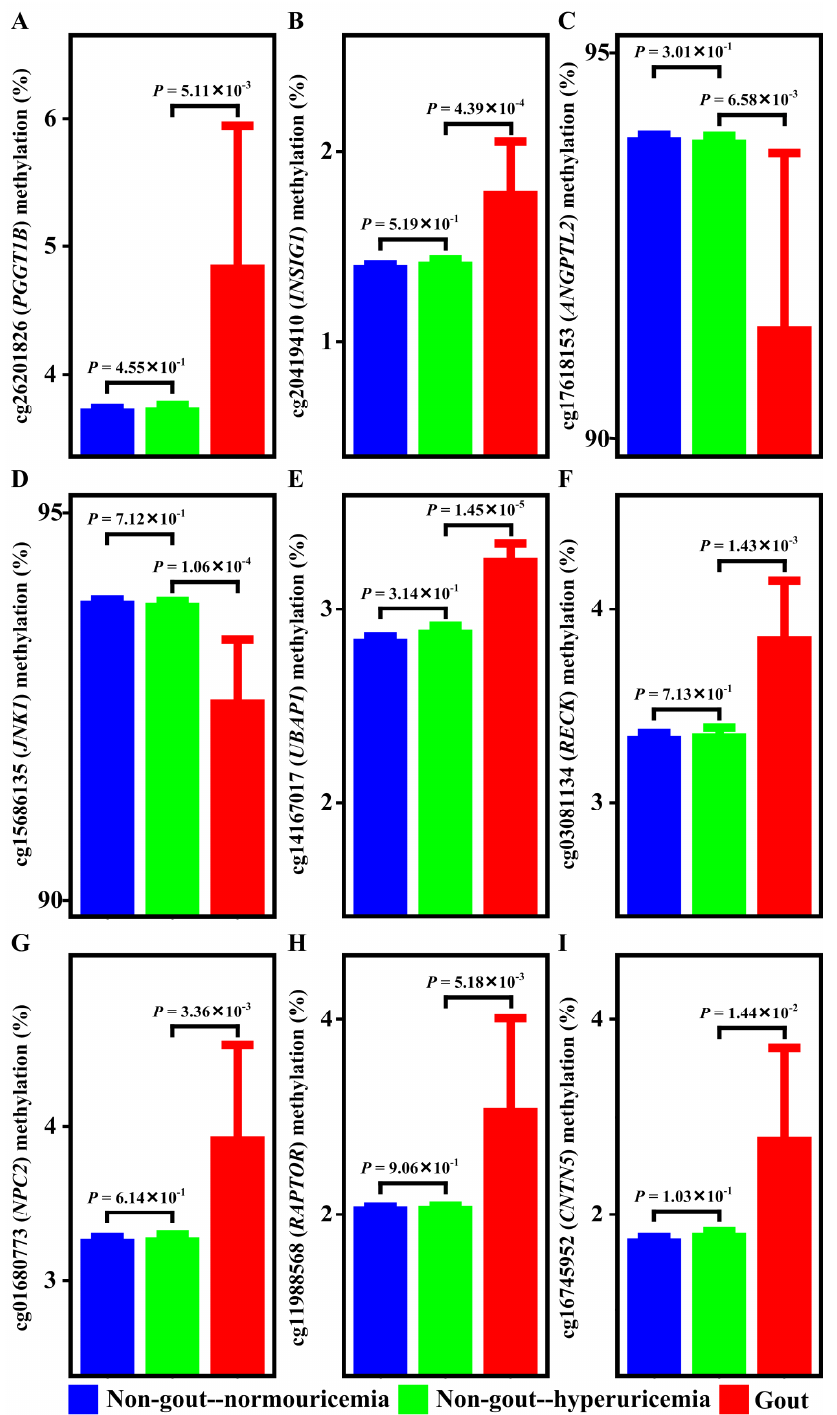
Figure 2. Methylation of PGGT1B , INSIG1 , ANGPTL2 , JNK1 , UBAP1 , RECK , NPC2 , RAPTOR , and CNTN5 in normouricemia, hyperuricemia, and gout. Methylation levels of PGGT1B ( A ), INSIG1 ( B ), ANGPTL2 ( C ), JNK1 ( D ), UBAP1 ( E ), RECK ( F ), NPC2 ( G ), RAPTOR ( H ), and CNTN5 ( I ) are similar between normouricemia and hyperuricemia patients. However, methylation levels of PGGT1B , INSIG1 , ANGPTL2 , JNK1 , UBAP1 , RECK , NPC2 , RAPTOR , and CNTN5 are different between hyperuricemia and gout. The methylation differences between groups are estimated with linear regression, correcting for sex, age, smoking history (total pack-years), smoking status, alcohol consumption, and blood cell subsets.